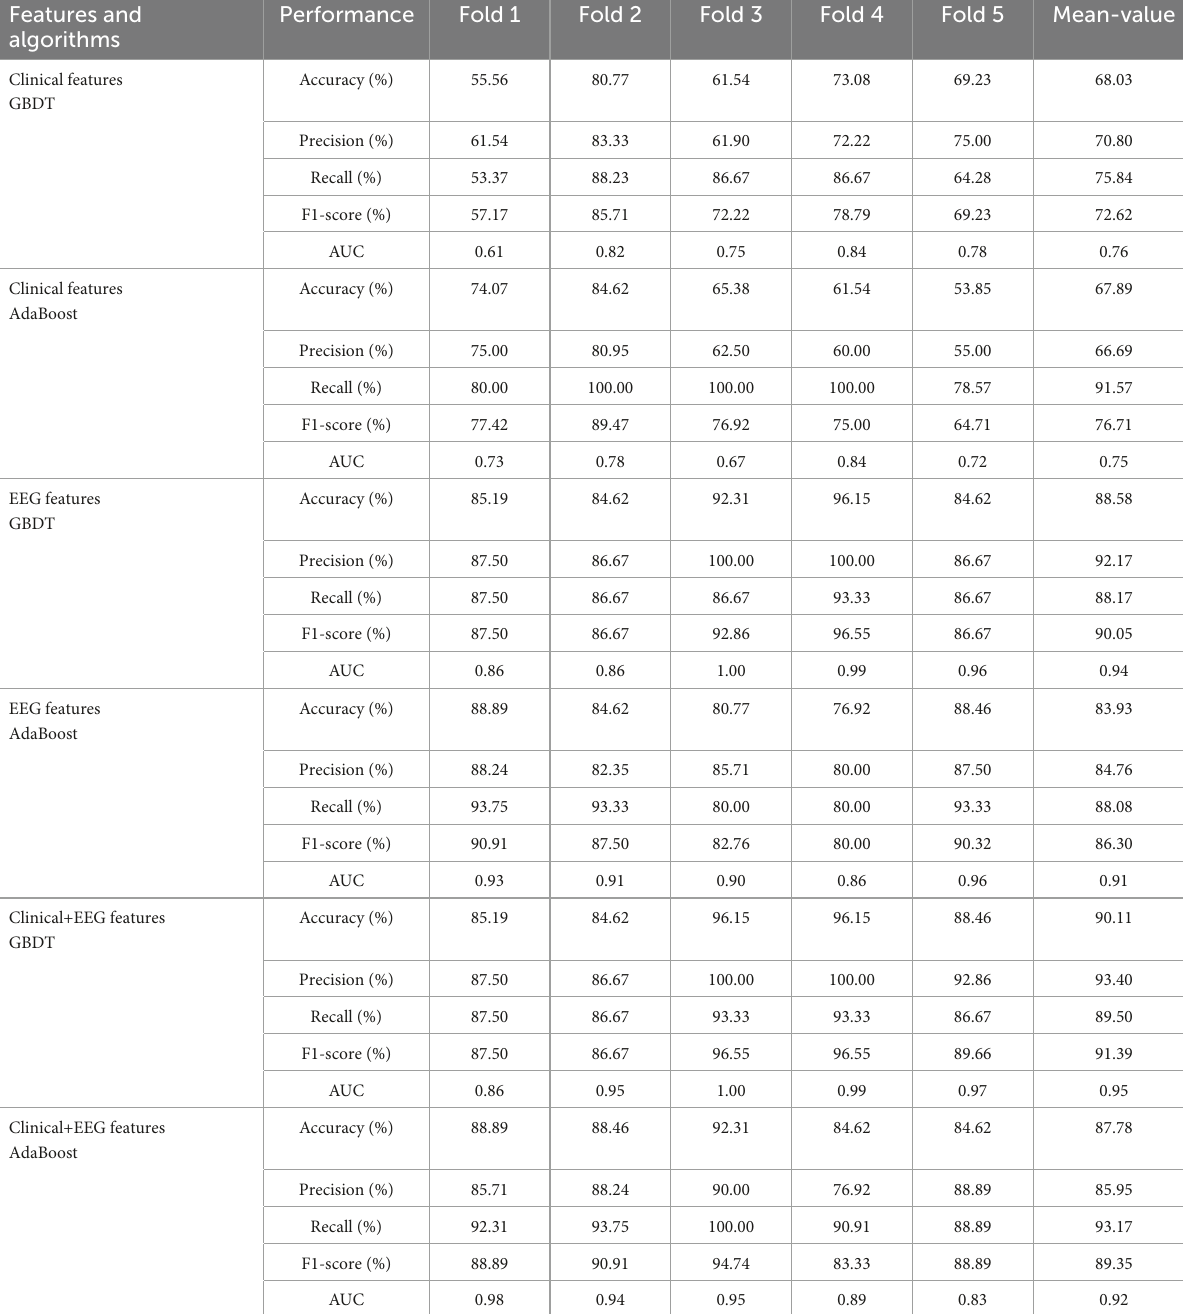
TABLE 5 The performance of the six classifier